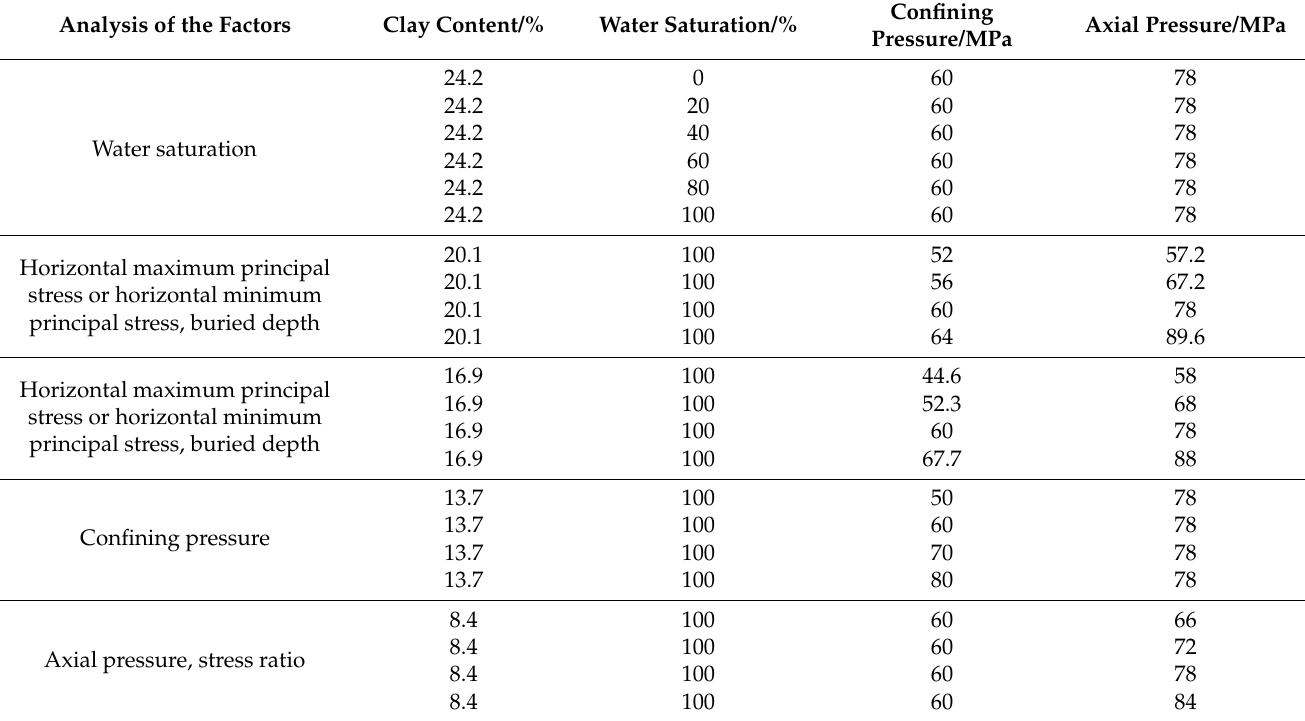
Figure 3. The stress ratio distribution frequency. Table 1. The experimental scheme.